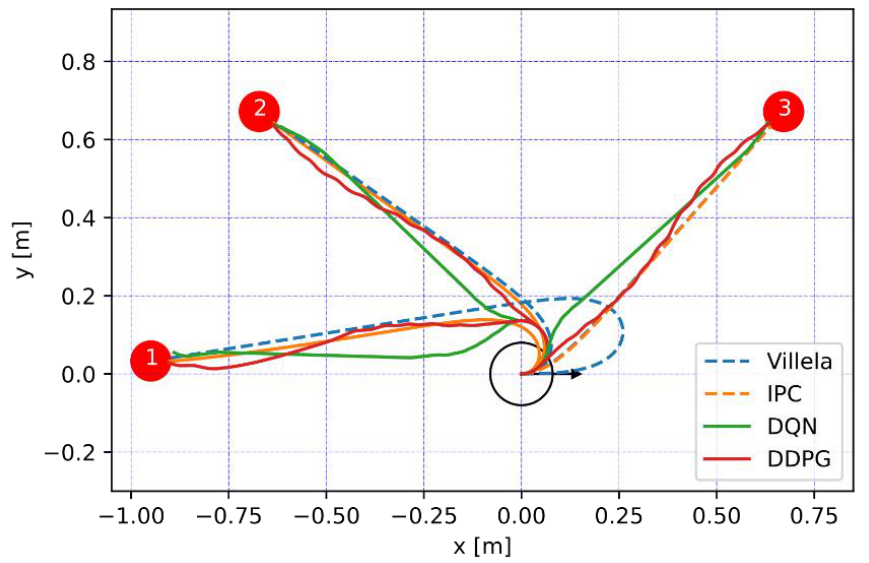
Figure 13. Graph of the trajectory for the three target points in the environment without obstacles.